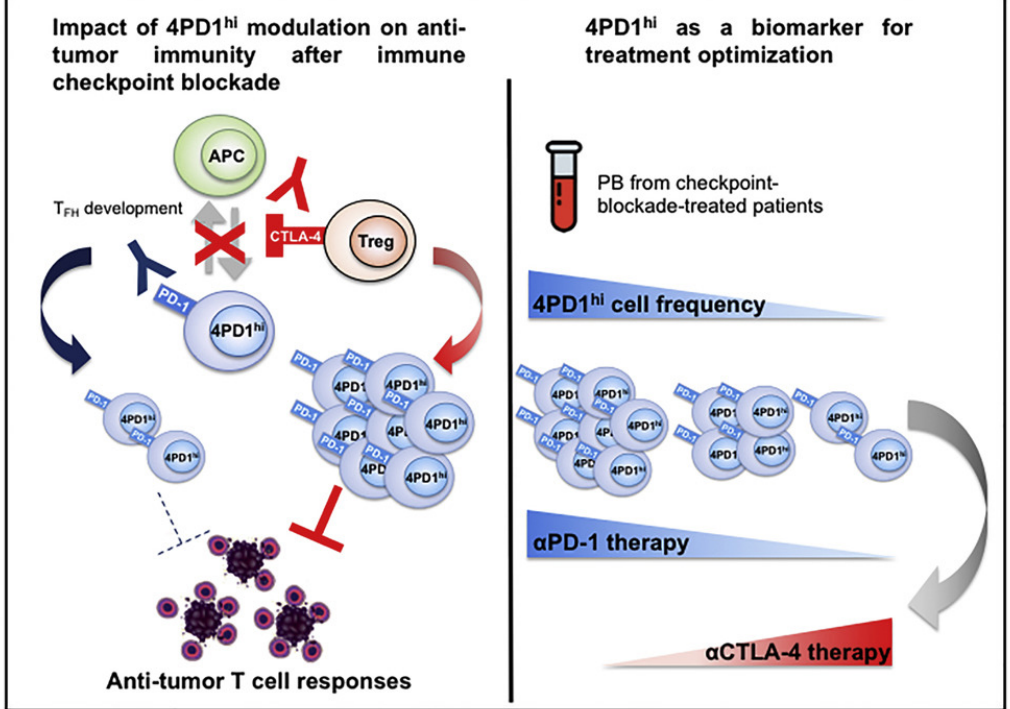
Figure 1. Zappasodi et al. illustrated the function of 4PD1 hi cells (PD-1 + CD4 + Foxp3 − T cells) and observed that these cells accumulate within the tumor as a function of the tumor burden. Reprinted with permission from Ref. [61]. 2018, Elsevier.